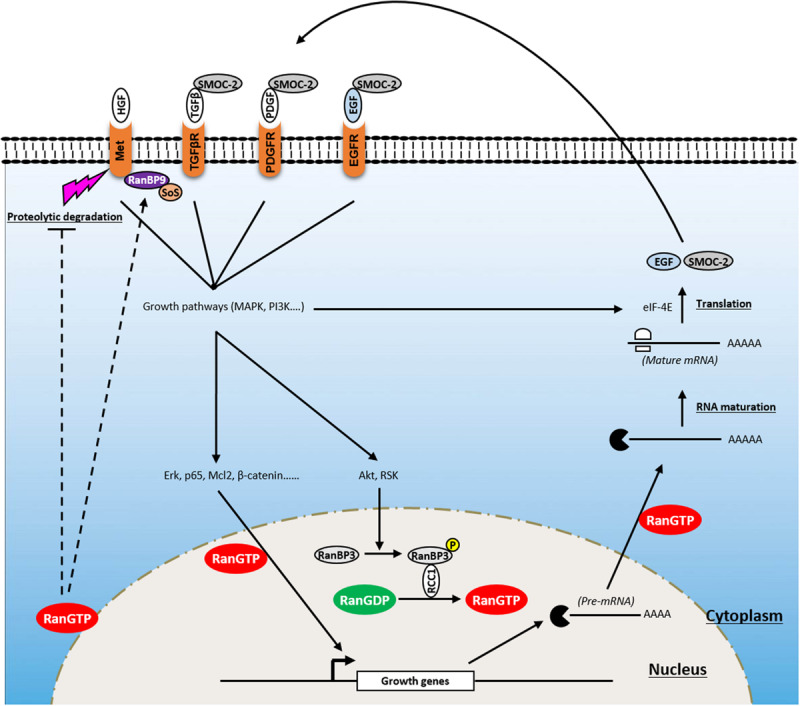
Involvement of Ran in proliferative signaling of cancer cells. Ran is a key player in a positive feedback loop that enhances growth signaling and promotes tumorigenesis. Owing to its ability to affect the import of critical transcription factors (i.e., Erk, p65, Mcl2, β-catenin), RanGTP transmits growth signals from the cytoplasm to the nucleus. RanGTP is also involved in the export of pre-mRNA which are further processed and translated into growth factors [i.e., epidermal growth factor (EGF), SMOC-2) which activate several tyrosine kinase receptors [i.e., EGF receptor (EGFR), platelet-derived growth factor receptor (PDGFR), transforming growth factor beta receptor (TGFβR)] after their release to the extracellular compartment. In addition, Ran is activated following the induction of growth signaling through the phosphorylation of RanBP3 by Akt and ribosomal protein S6 kinase (RSK). Furthermore, besides its ability to modulate the activity of these receptors, Ran is involved in supporting Met signaling through (i) its stabilization by blocking its proteolytic cleavage by metalloproteases and preventing receptor shedding and (ii) the activation of RanBP9 that recruits Son of Sevenless (SoS) which acts upstream of the GTPase Ras.